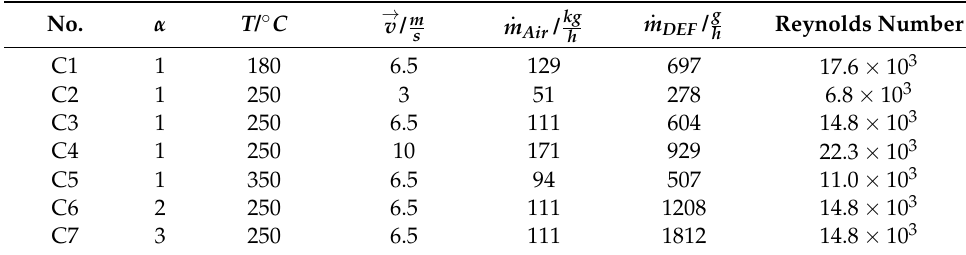
Table 1. Operating conditions considered in this study.